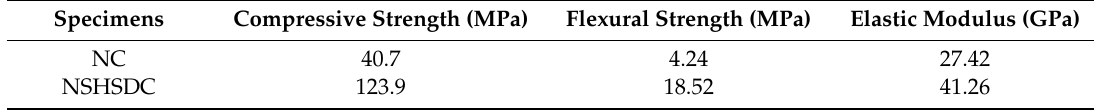
Table 4. Mechanical properties of